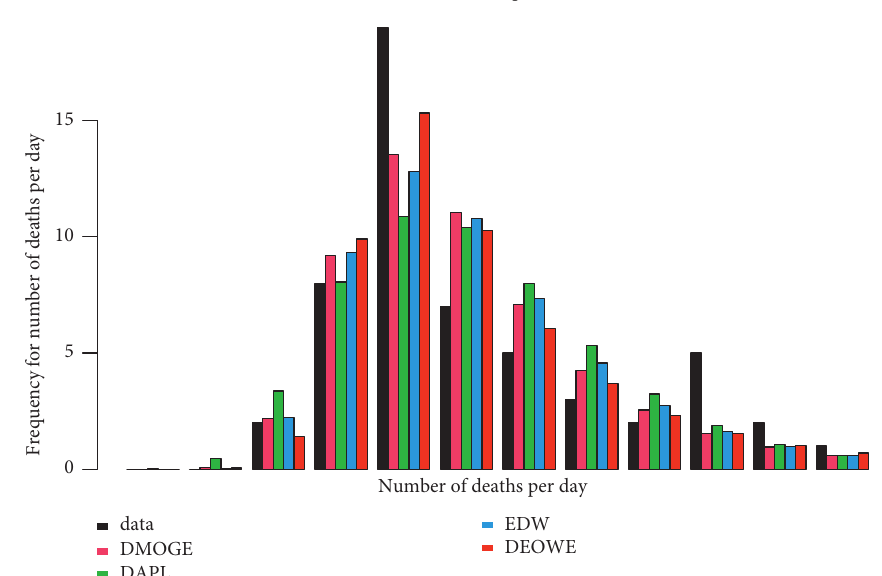
Figure 5: Graphical plots for the expected frequencies and the data using the PMF of different three-parameter distributions, where the x - axis represents the number of deaths per day and the y -axis represents the frequency for this number.